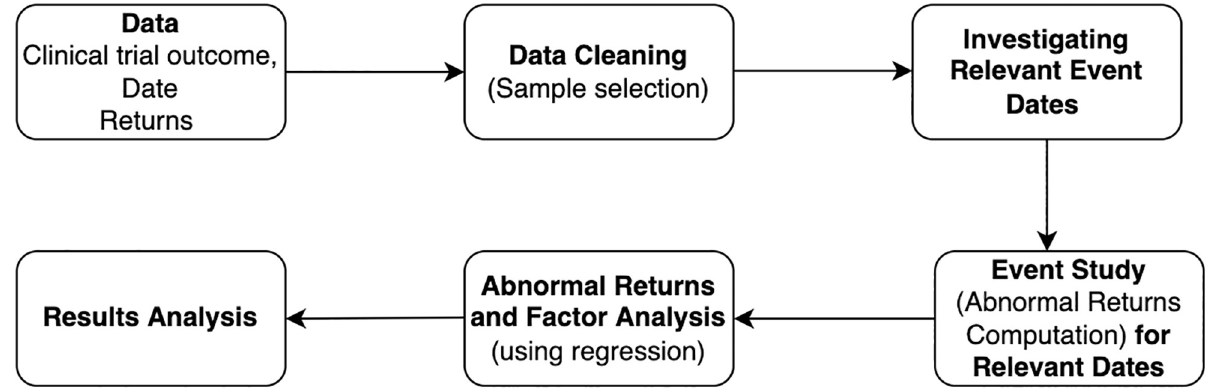
Fig 1. This plot diagrams the steps involved in this event study, from the initial data collection to the analysis of our results.